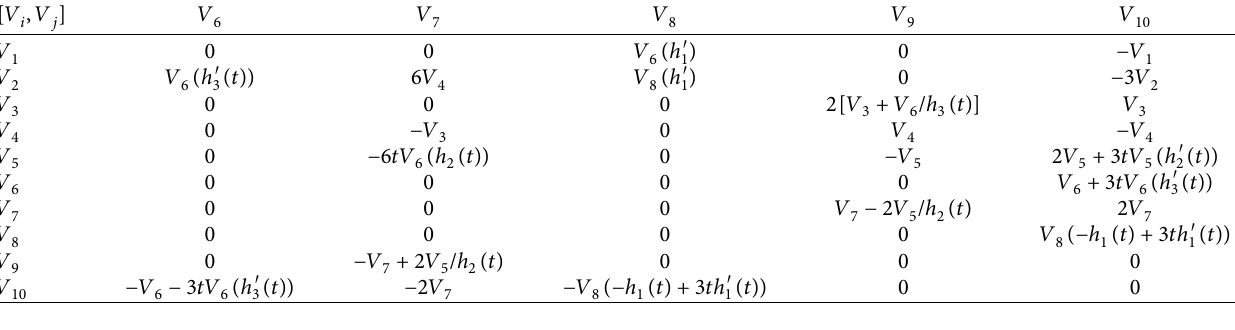
Table 2: Commutator